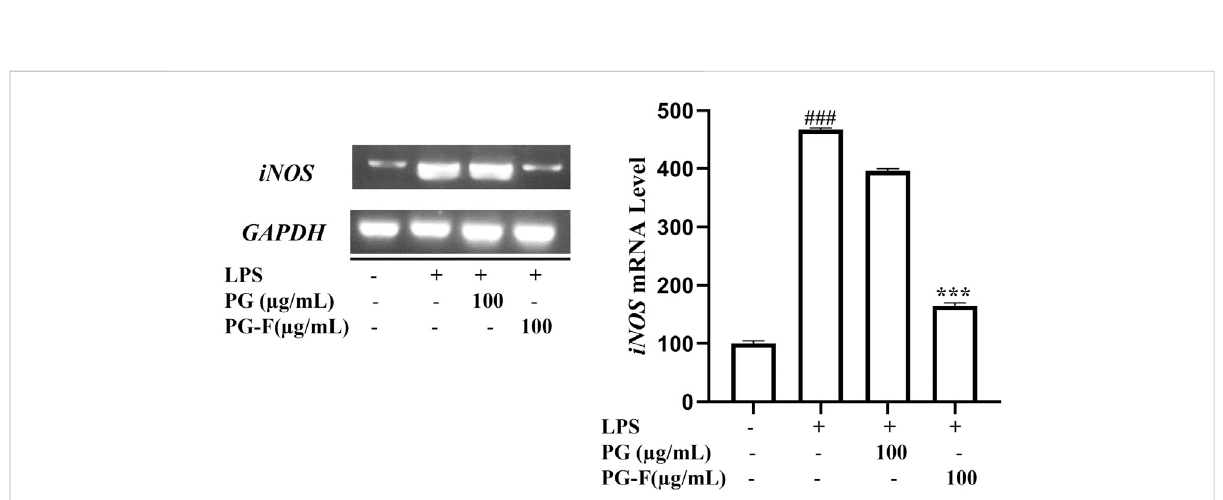
FIGURE 6 Effect of Pomegranate on the mRNA expression of iNOS in RAW 264.7 cells. AW 264.7 macrophages were pretreated with Pomegranate juice for 1 h, then stimulated with LPS (1 μ g/ml) for 24 h. Finally, total RNA was extracted, and the mRNA expression levels were determined by RT-PCR analysis and compared with those of GAPDH. The data shown are representative of the mean values of three independent experiments ±SD. *** p < 0.001 as compared with the group treated with LPS, and ### p < 0.001 as compared to the